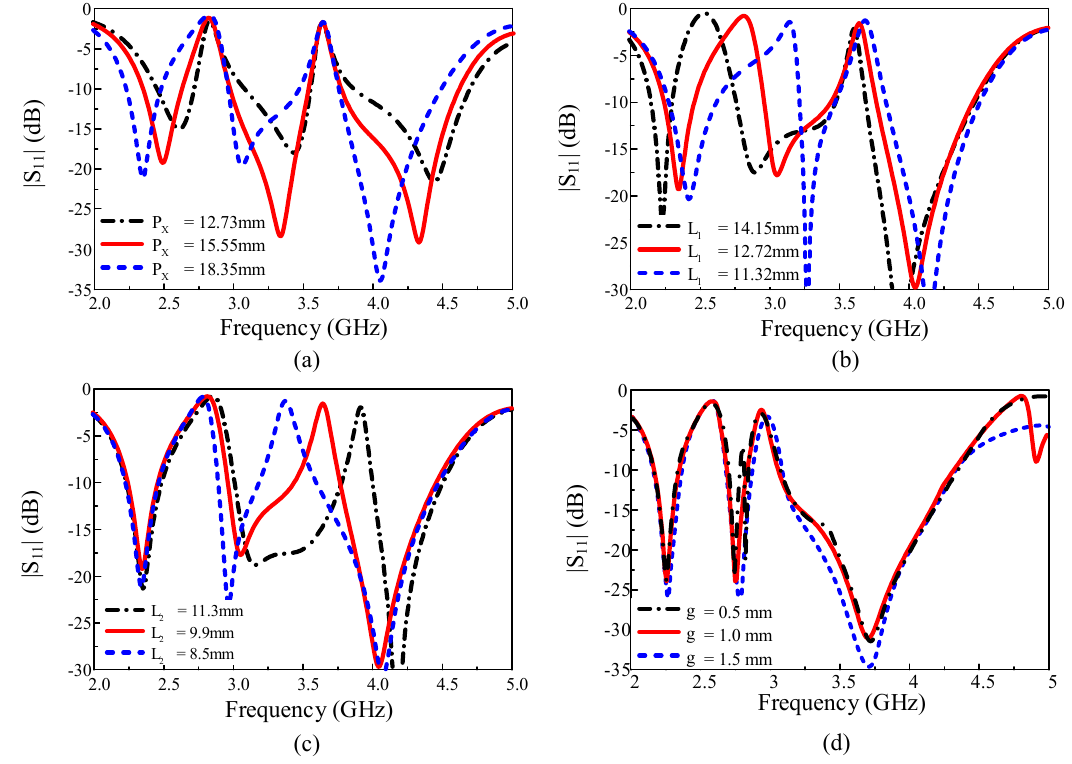
Figure 6. Parametric analysis of the various parameters of the antenna: ( a ) P X ( b ) L 1 ( c ) L 2 ( d ) g.